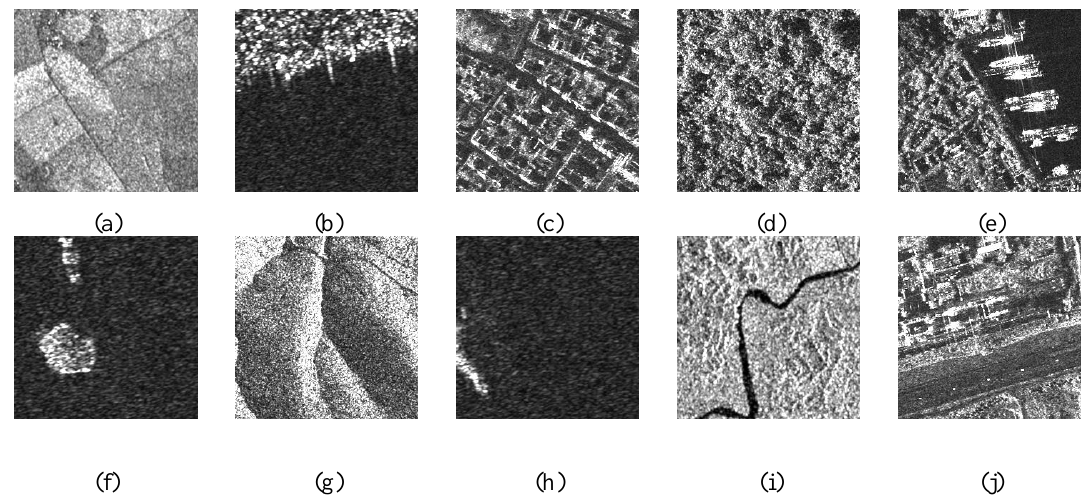
Figure 6. Example images from the TerraSAR-X dataset: ( a ) agricultural; ( b ) beach; ( c ) building; ( d ) forest; ( e ) intersection; ( f ) island; ( g ) mountain; ( h ) ocean; ( i ) river; ( j ) runway.